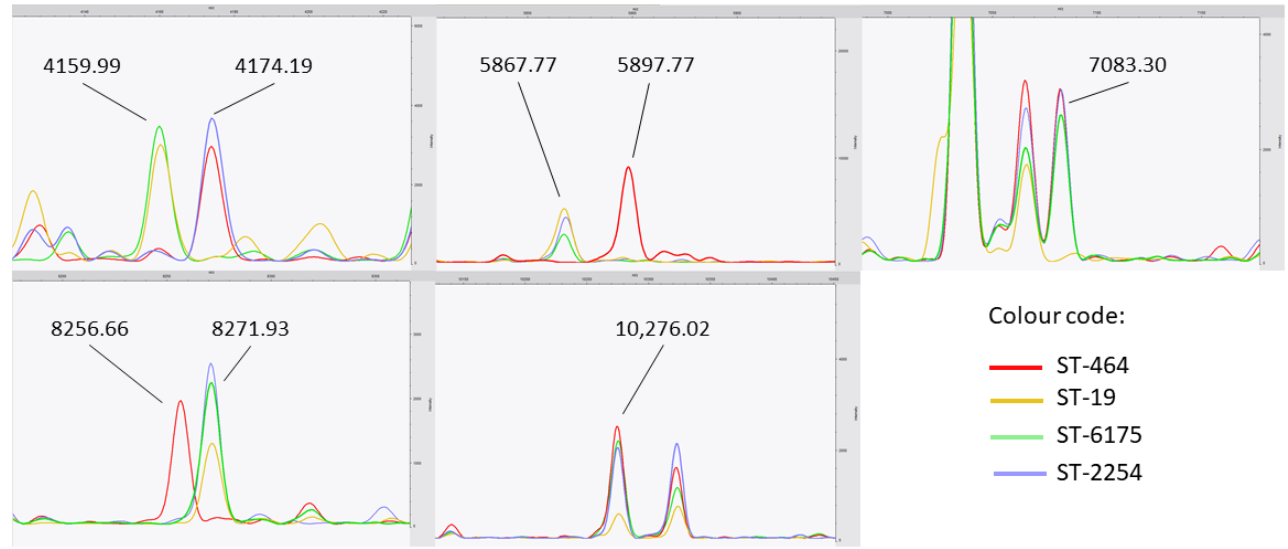
Figure 3. Decision tree trained on the peak matching table with intensity values from the complete dataset ( n = 91 MSPs) grouped by their ST profiles. Maldi: peak feature; Gini: measures the probability of misclassifying an observation; samples: illustrates how many samples the node contains; value: refers to how many samples at the node fall into each ST category.